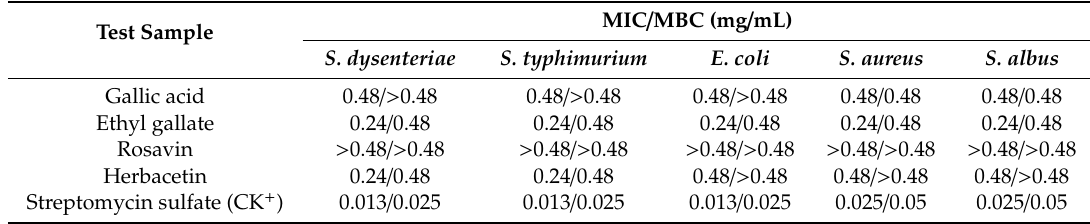
Table 4. The MIC and MBC values of the compounds from R. crenulata against pathogenic bacteria.